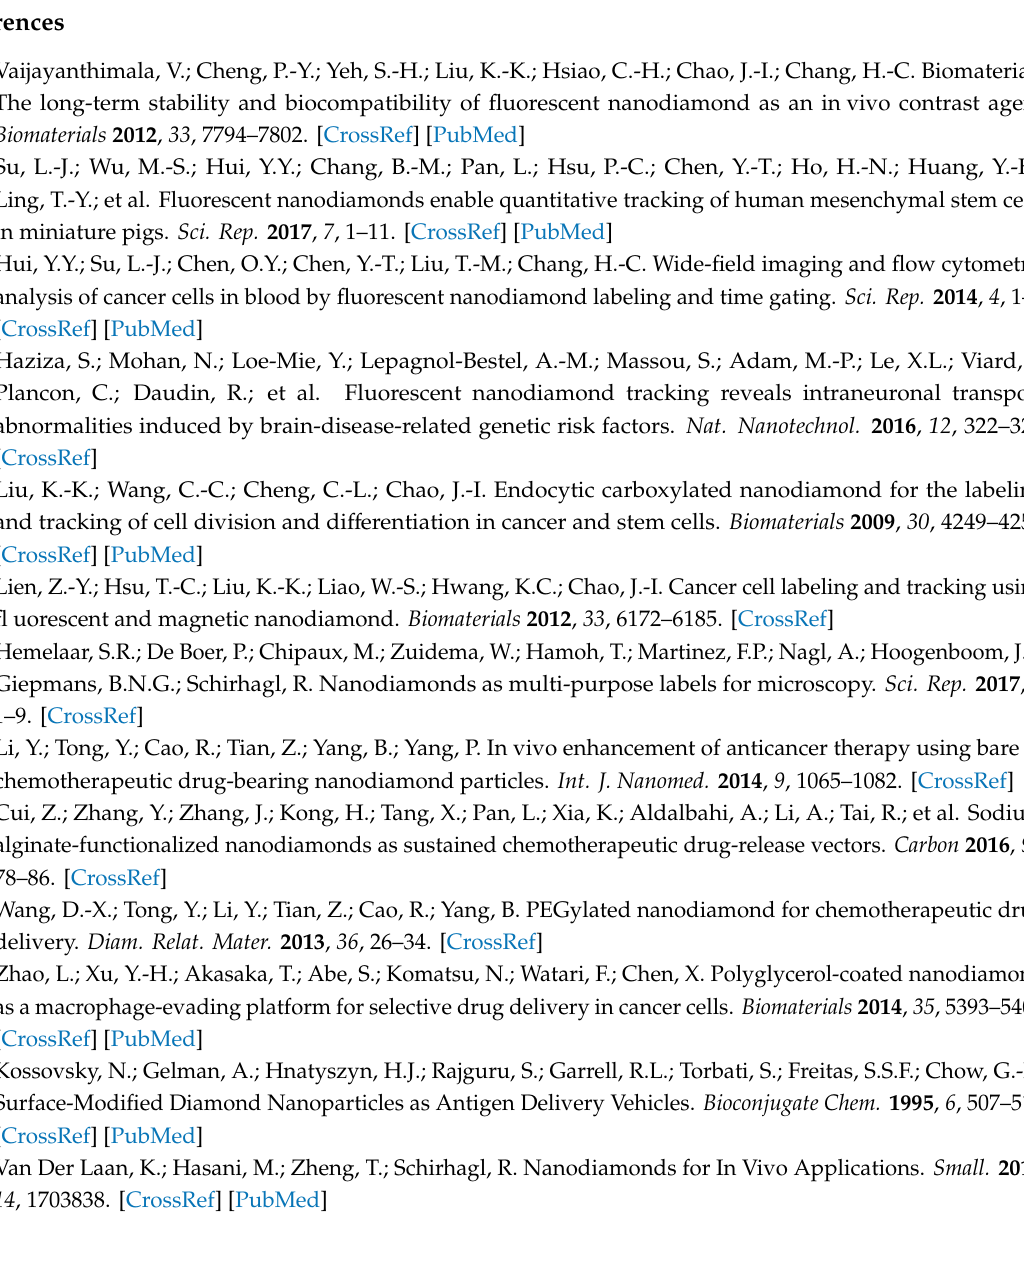
Figure S1: Average of value of zeta potential from FND and FND-AB particles in water, Figure S2: Average value of particle size distribution from FND and FND-AB in water, Figure S3: Average values of zeta potential from FND and FND-AB in yeast medium, Figure S4: Average value of particle size from FND and FND-AB in yeast medium, Figure S5: FTIR spectra of FND and FND-AB particles, Figure S6: ODMR spectra of FND and